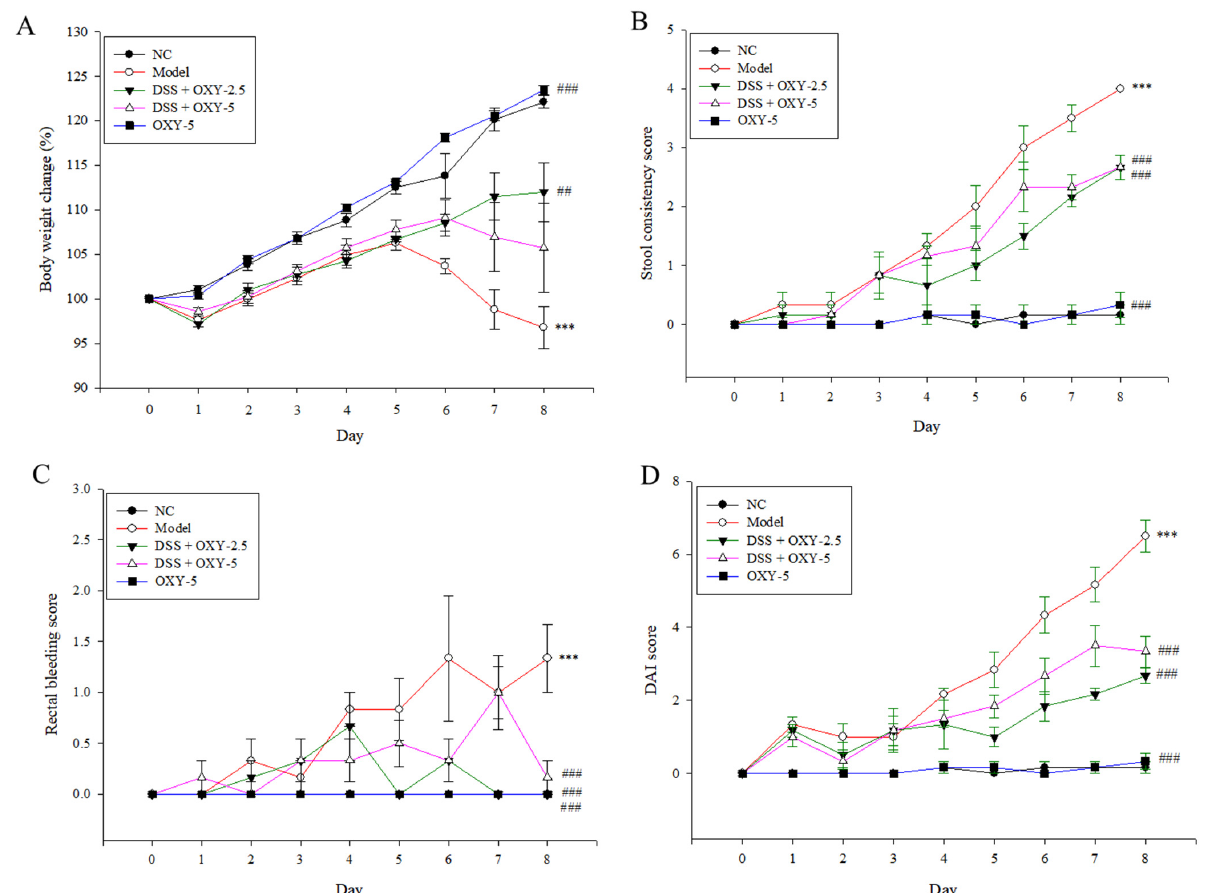
Figure 1. Disease-alleviating effect of oxyresveratrol (OXY) in a dextran sulfate sodium (DSS)-induced colitis rat model ( n = 8/group). Daily changes of body weight ( A ), stool consistency ( B ), and rectal bleeding ( C ) were monitored, and the disease activity index (DAI) score was calculated by summing scores of these three parameters ( D ). NC, normal control group; model, DSS-induced colitis model group; DSS + OXY-2.5, DSS-induced colitis rats treated with OXY (2.5 mg/kg) group; DSS + OXY-5, DSS-induced colitis rats treated with OXY (5 mg/kg) group; OXY-5, rats treated with OXY (5 mg/kg) alone group. The values are expressed as mean ± SEM. Significant differences among groups were evaluated via ANOVA with Tukey’s post hoc HSD. *** p < 0.001 compared with the NC group; ## p < 0.01 and ### p < 0.001 compared with the model group.